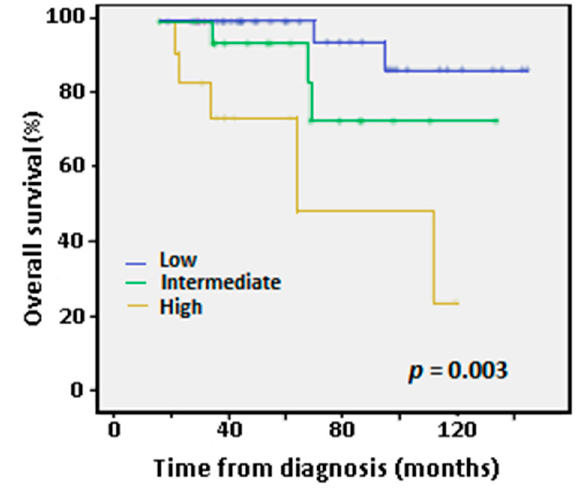
Figure 1. Kaplan-Meier curves for overall survival (OS) at five years according to International Prognostic Index (IPI) low-, intermediate- and high-risk categories. Only two patients belonged to the very high-risk group and were not considered in this analysis because they were of recent diagnosis and lacked follow-up. p -value according to Log-Rank test.